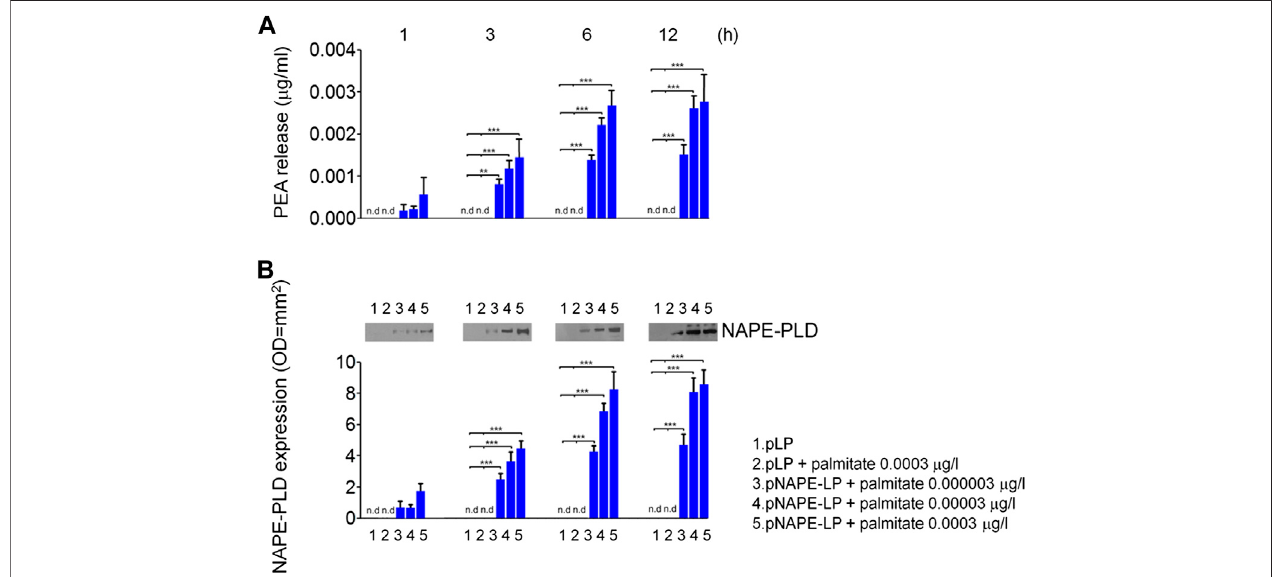
FIGURE 1 | PEA is released in vitro by engineered NAPE-PLD Lactobacillus paracasei under palmitate dose and time dependent boost. (A) PEA release was evaluated in bacterial supernatants at 1, 3, 6, and 12 h, respectively, by HPLC – MS, and the results are expressed as mean ± SEM of n (cid:2) 4 experiments performed in triplicate. Compared with pLP in absence of palmitate supply, exogenous palmitate (0.000003 – 0.0003 μ g/l) dose- and time-dependently increased PEA release from pNAPE-LPprobiotics,*** p < 0.001,** p < 0.01vs.bothpLPandpLPinpresenceofpalmitate0.0003 μ g/l.PEAlevelswereundetectableinpLPsupernatants,even inthepresenceofthehighesttesteddosesofexogenouspalmitate(0.0003 μ g/l).Inthesameconditions, (B) WesternblotanalysisofNAPE-PLDexpressionandrelative densitometricanalysisofimmunoreactivebandsshowthatNAPE-PLDproteinexpressionistime(1,3,6,and12 h)andpalmitateconcentration(0.000003 – 0.0003 μ g/l) dependent in pNAPE-LP engineered bacteria, whereas no expression was noticeable in pLP alone at the different time points, even in the presence of the highest palmitate doses (0.0003 μ g/l). *** p < 0.001 vs. both pLP and pLP + palmitate 0.0003 μ g/l n. d.,